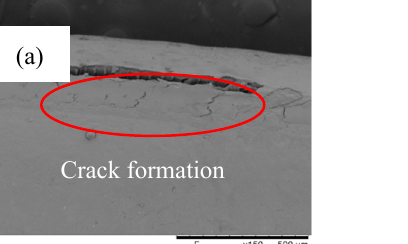
Figure 3. Precipitation of a polypropylene (PP) coating from the non-solvent–solvent interaction on the PVDF hollow fiber surface.